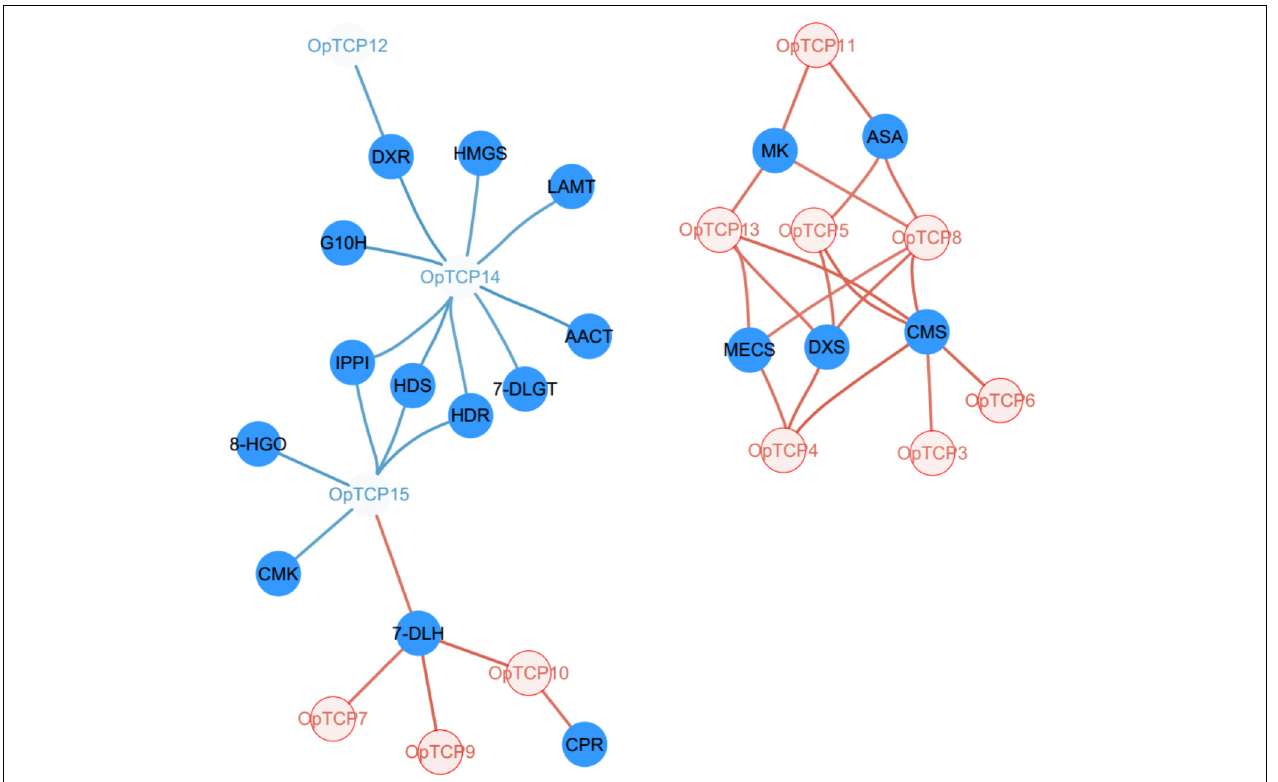
FIGURE 6 | Regulatory network of TCP transcription factors and key CPT-biosynthetic genes. The colored fonts represent TCP TFs and the solid blue circles represent CPT-biosynthetic genes. The edges are drawn when the absolute value of the linear correlation coefficient is > 0.8. The blue and red line represents the negative correlation and positive correlation, respectively. TCP, teosinte branched 1/cycloidea/proliferating cell factors 1/2; CPT,